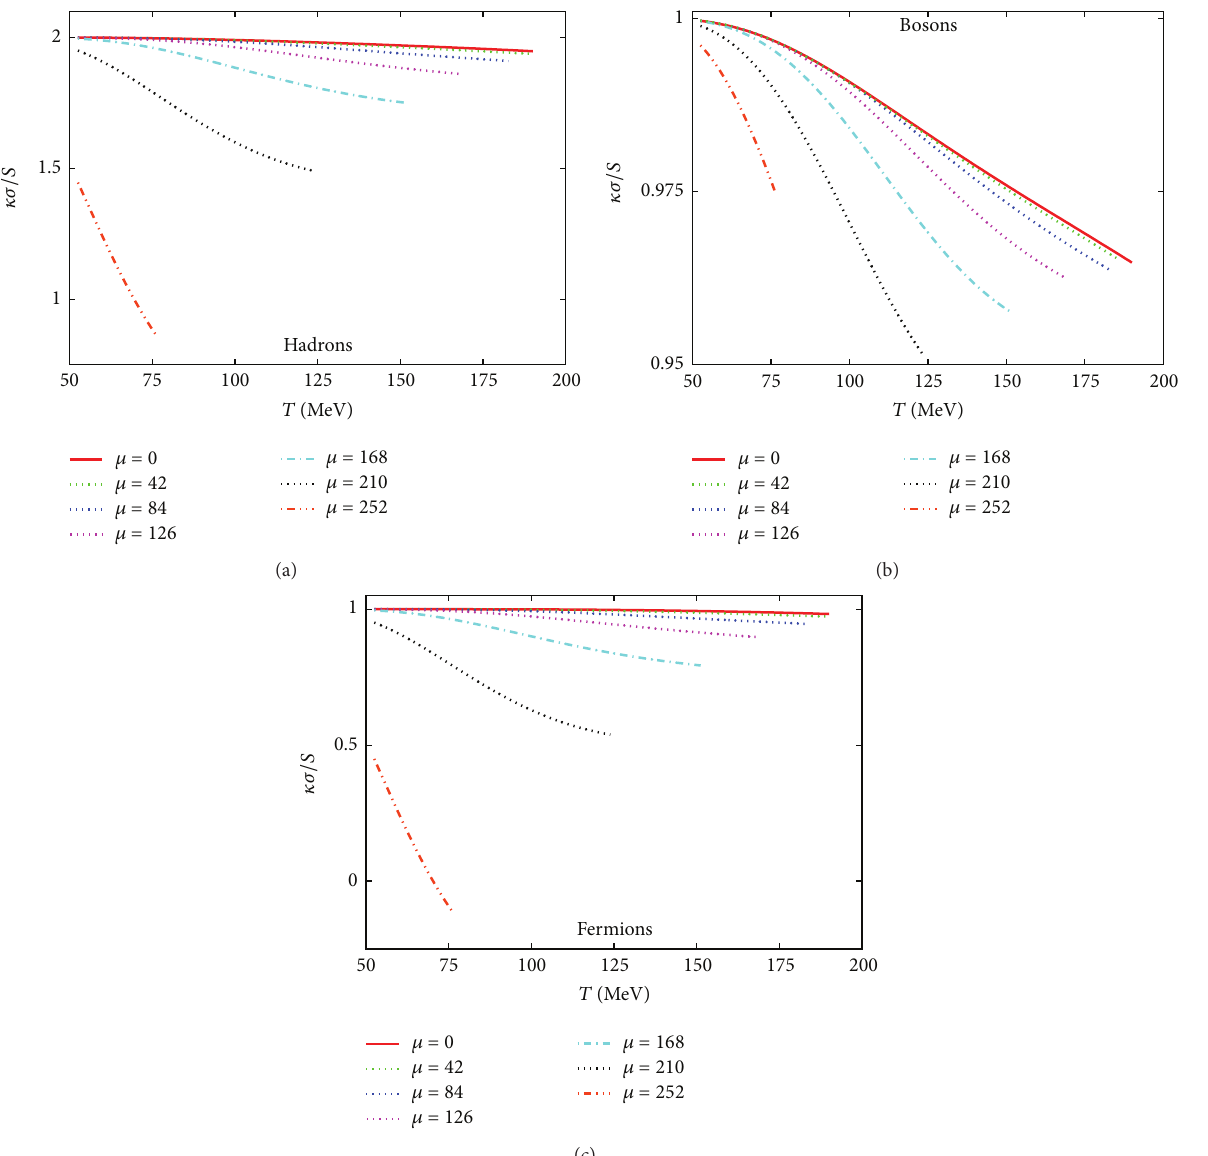
Figure 8: 𝜅𝜎/𝑆 as a function 𝑇 at different chemical potentials for hadrons (a), bosons (b), and fermions (c).